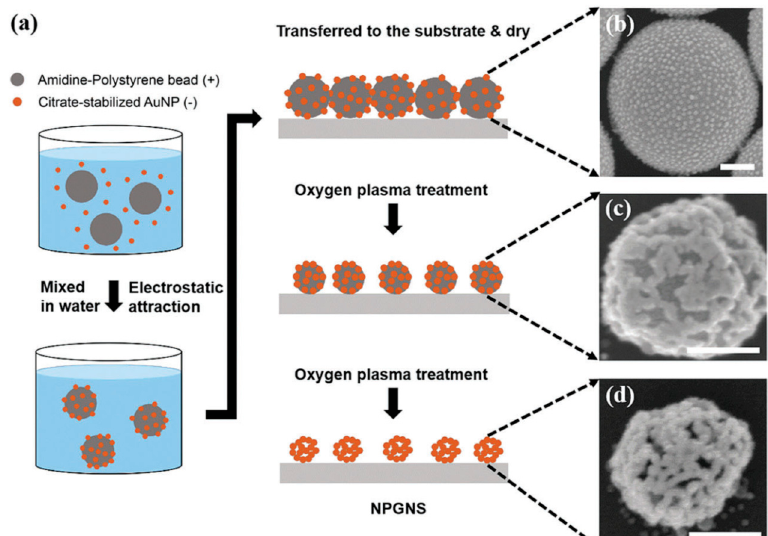
Figure 8. ( a ) Procedure for the synthesis of AuNCs by starting form polysterene beads. ( b – d ) SEM images of each intermediate step (scale bar 200 nm). Reproduced from [65] with permission from Elsevier.